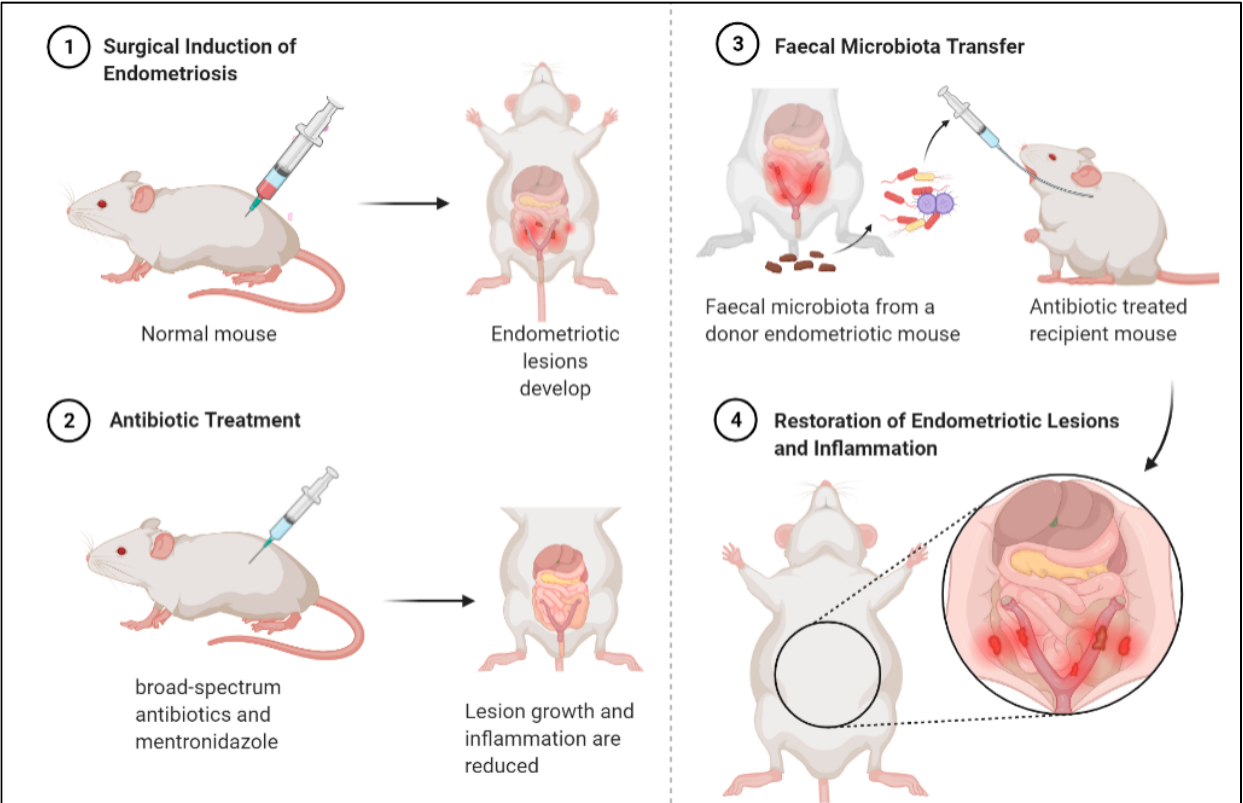
Figure 4. Antibiotic treatment can reduce endometriotic lesion growth and peritoneal inflammation, and subsequent faecal microbiota transfer from diseased mouse can restore lesion growth and inflammation. Mouse experiment demonstrates bidirectional relationship between endometriosis and gut